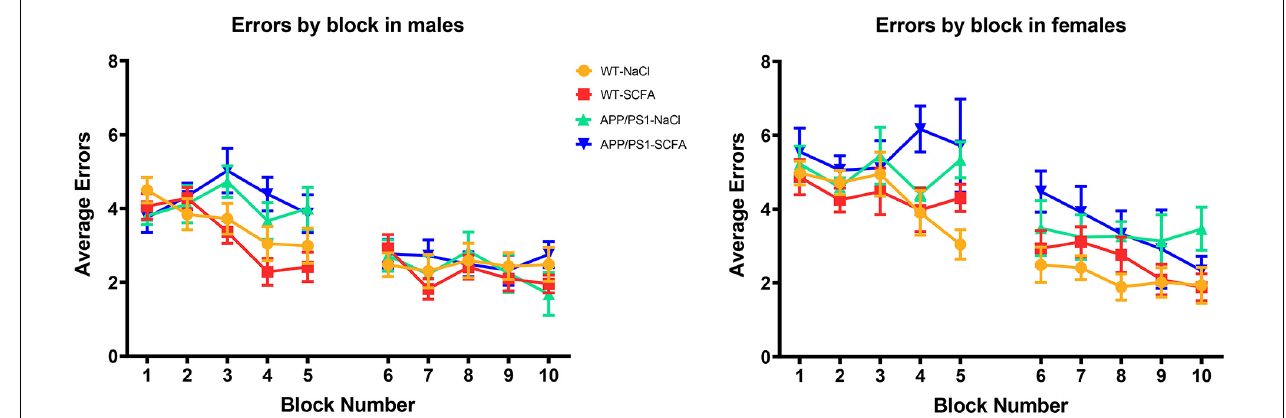
FIGURE 5 | RAWM results for day one and day two trials. Data are represented as means of three trials per block of all animals within the group, with five blocks per day. Day one was training day, while day two was testing day. Error bars are standard deviation of the mean.